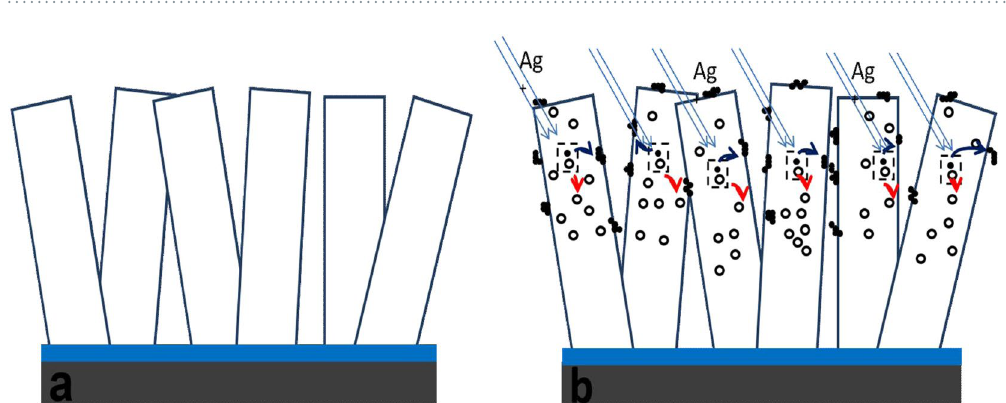
Figure 8. Schematic diagrams which show the generation, migration and accumulation of interstitials and vacancies in ZnO NRs ( a ) before and ( b ) after 150 MeV Ag 11 + ion beam